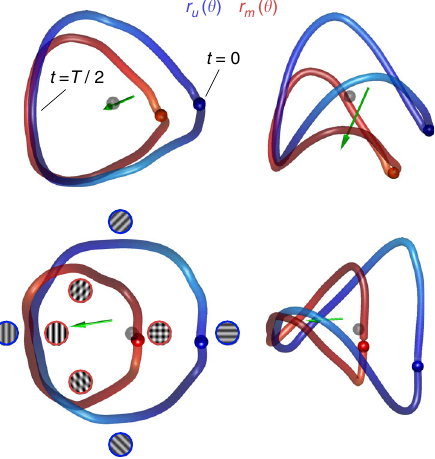
Fig. 4 Multidimensional scaling (MDS) of population responses in unmasked and masked conditions. Each row shows two viewpoints of the result of one experiment. The curves were obtained by performing MDS simultaneously on the population responses in unmasked and masked conditions into 3D space using the cosine distance as a metric. The blue curve shows r u θ ð Þ and the red curve shows r m θ ð Þ . The gray sphere represents the origin, and colored spheres represent the beginning of the cycle. The green arrows represent the shift in the white point between conditions. The stimuli represent the patterns at different locations on the curves for the two conditions (blue outline — unmasked condition, red outline — masked condition). The icons on the bottom left represent the con fi guration of the stimulus along different parts of the